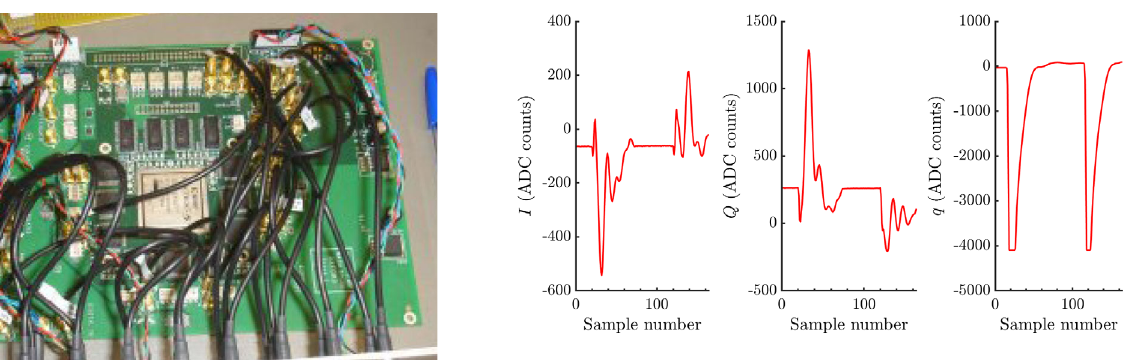
FIG. 9. Representative digitized I , Q and q waveforms from IPC, for two-bunch-train operation with a bunch spacing of 280 ns. The waveforms were sampled at intervals of 2.8